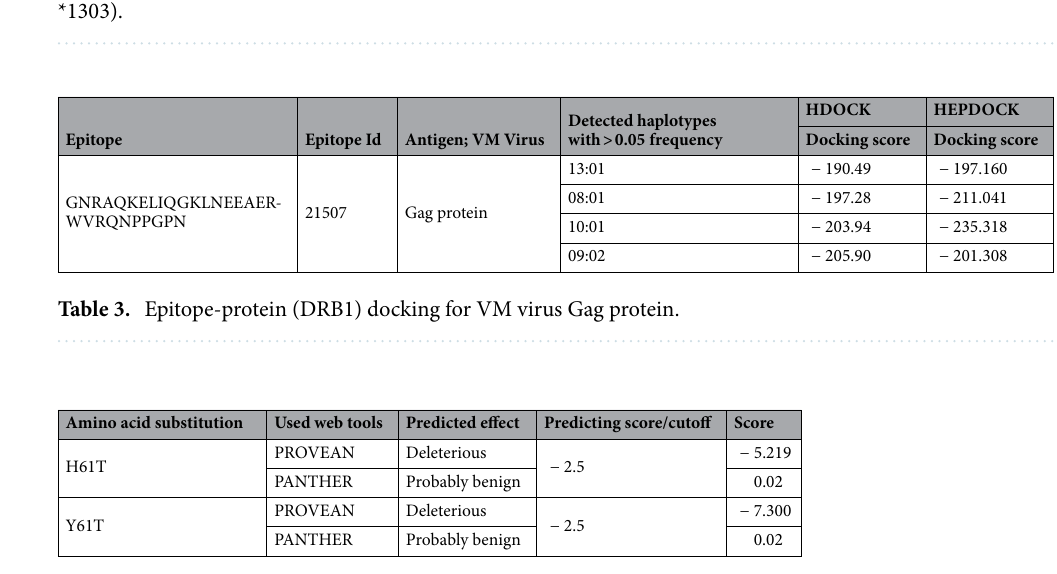
Table 4. Point mutation effect prediction of the (H/Y) to (T) amino acid replacement at codon position 61. PROVEAN: Variants with a score equal to or below − 2.5 are considered “deleterious”, variants with a score above − 2.5 are considered